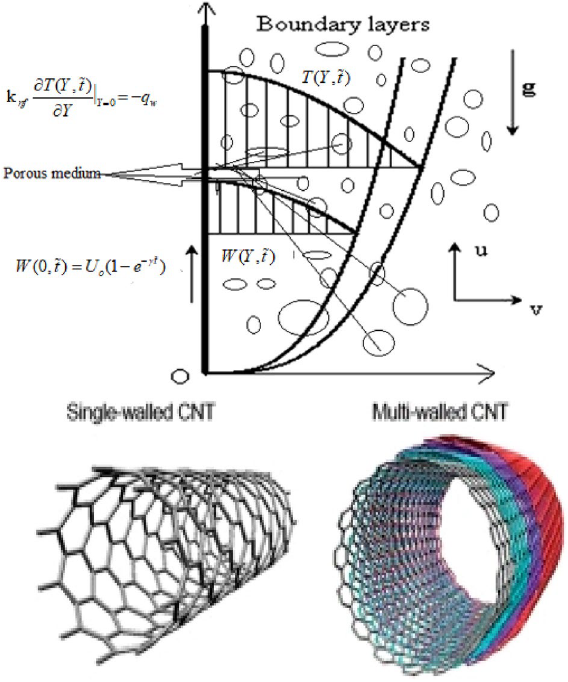
Figure 1. Geometry of the flow